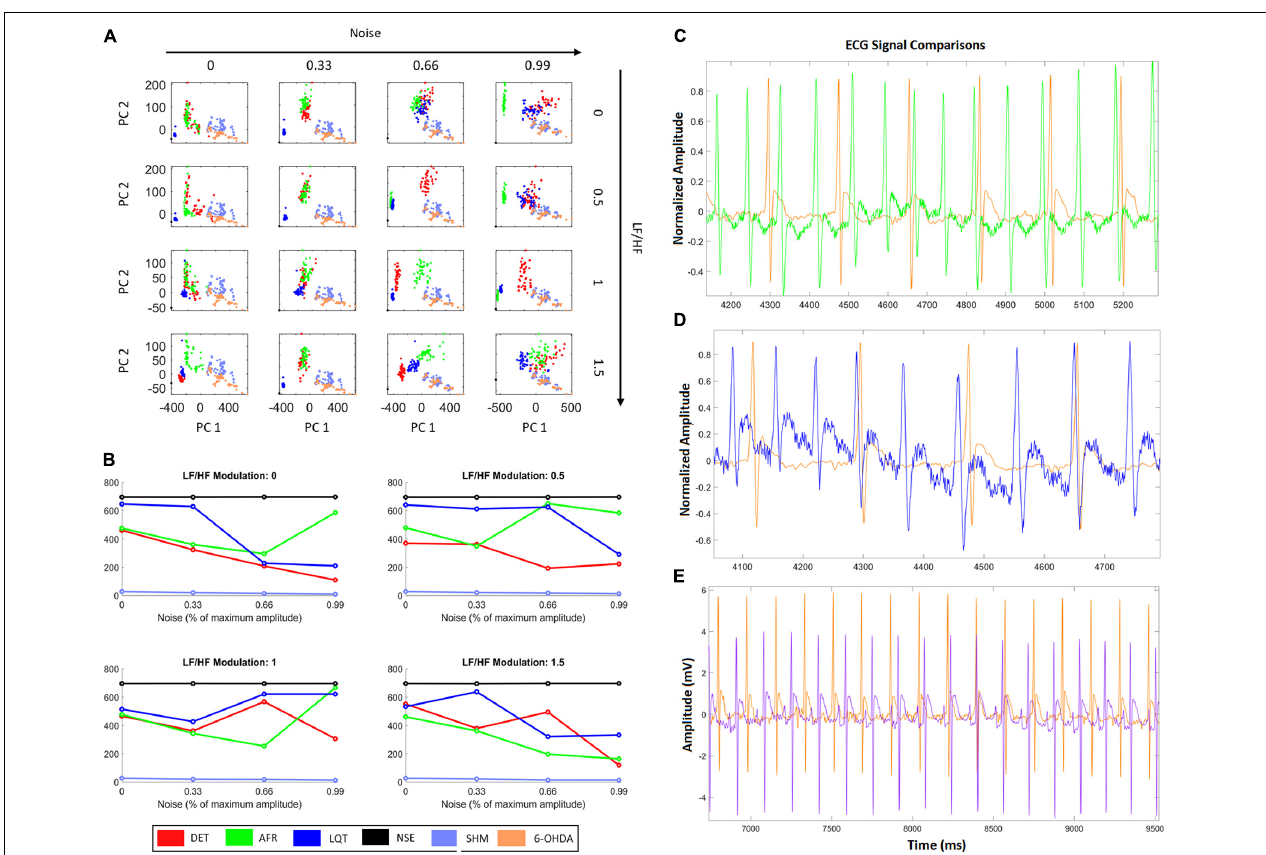
FIGURE 7 | HRV characteristics combined with RQA metrics from aECG and ECG animal models. (A) Projections of RQA factors calculated from the animal ECGs onto the principal components space constructed from the RQA factors calculated from the four aECG patterns. (B) The distances calculated from all centroid clusters in relation to the 6-OHDA centroid cluster, considering the different conditions in terms of HRV modulation and noise intensity. The closest cluster (related to real ECGs) are the cluster from DET aECG pattern for all conditions of HRV and noise. There is an alternation of the distance values, that occurs mainly for high levels of noise, where atrial fibrillation (AF) and Long-QT Syndrome (LQT) change their centroid values. It indicates that high noises in tachograms could interfere in standard metrics. (C) Comparison of AF to 6-OHDA for LF/HF modulation equal to 1.5 and noise equal to 99%. Both signals look similar, where their centroid cluster distances exhibit the lowest distance values. (D) It shows an example of LQT aECG pattern considering a noise intensity equal to 99% and LF/HF modulation equal to 0, compared with 6-OHDA ECG signal. The proximity of P-waves and T-waves suggests all signals exhibit only QRS-complexes and one bi-event defined by the union of P and T waves. (E) Differences between 6-OHDA and Sham